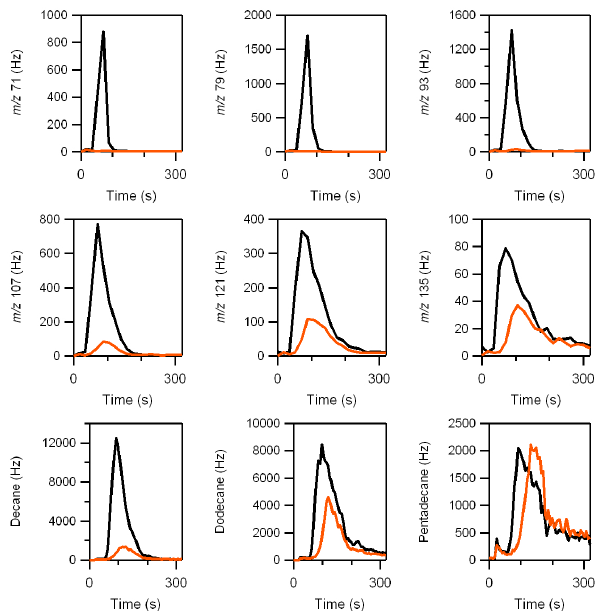
Fig. 8. PTR-MS IVOC mode desorption peaks of selected com- pounds for 30 ◦ C (blue trace) and 150 ◦ C purge (red trace) temper- atures: methacrolein ( m/z 71), benzene ( m/z 79), toluene ( m/z 93), p-xylene ( m/z 107), 1,2,4-trimethylbenzene ( m/z 121) and 1,2,3,5- tetramethylbenzene ( m/z 135), decane ( m/z 57, 71, 85, 99), dode- cane ( m/z 57, 71, 85, 99), and pentadecane ( m/z 57, 71, 85, 99). The ion signal (Hz) is normalized to MHz H 3 O + .